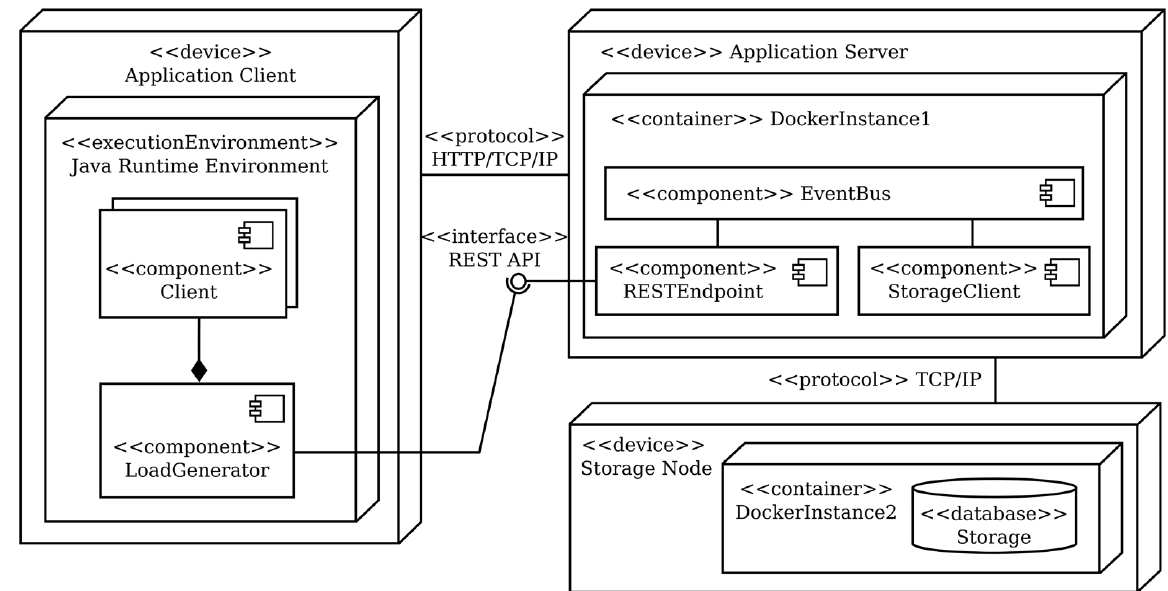
Figure 17. UML deployment diagram of the experiment setup.